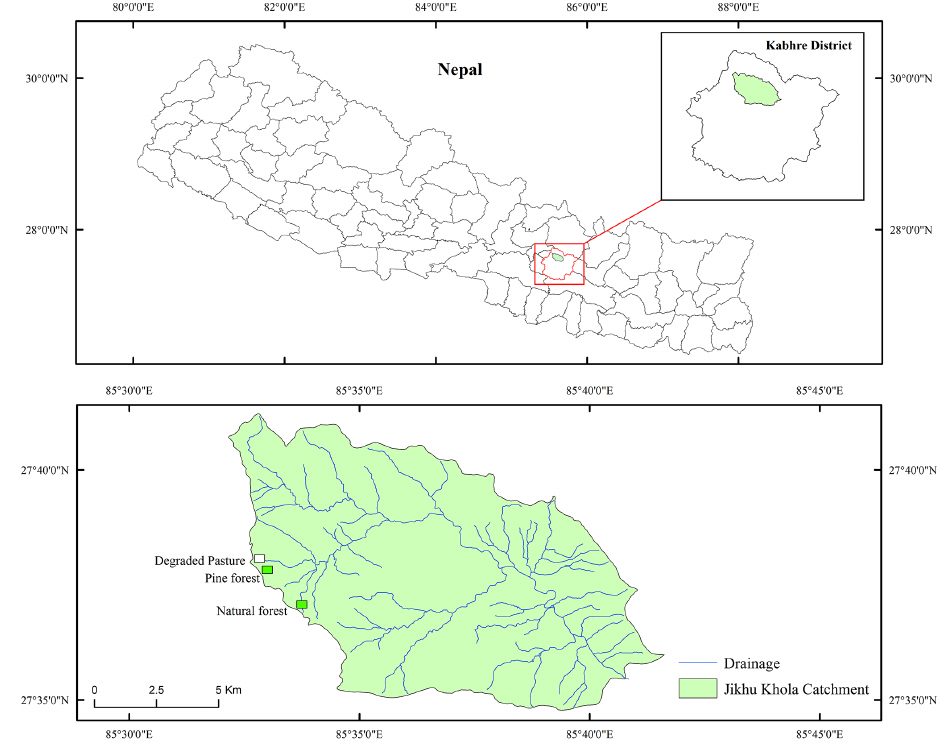
Figure 1. Location of the study sites in the Jikhu Khola catchment in the Middle Mountains of central